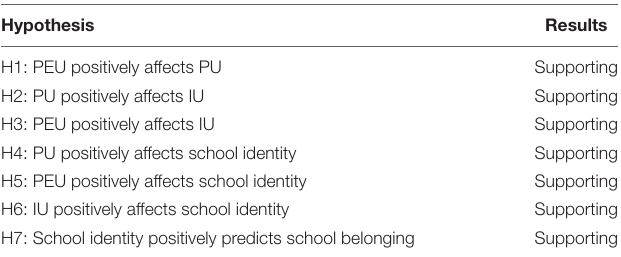
TABLE 2 | Results of H1 ∼ H7.